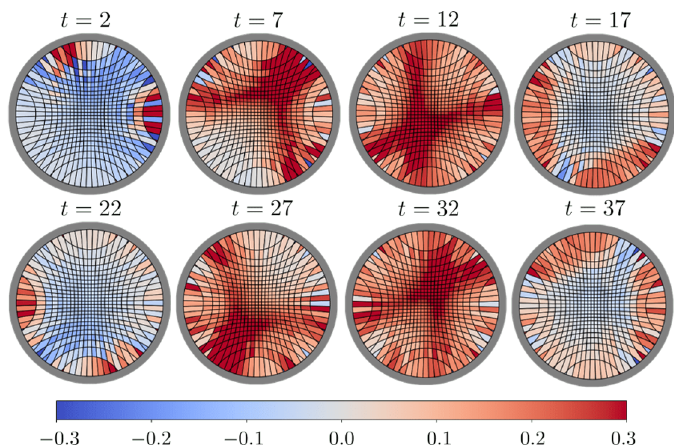
Figure 8. Quenched time dynamics of the reconstructed geometry corresponding to a mass de- formation at two distinct sites ( S = { 0 , 30 } ). The boundary data is pre-processed by smoothing to remove small-scale details. The trace of h ij is shown here. The boundary relative error is E bdy ≈ 0 . 05